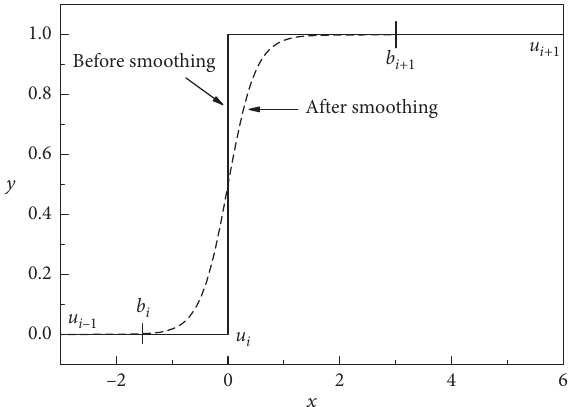
Figure 12: Calculation interval diagram.